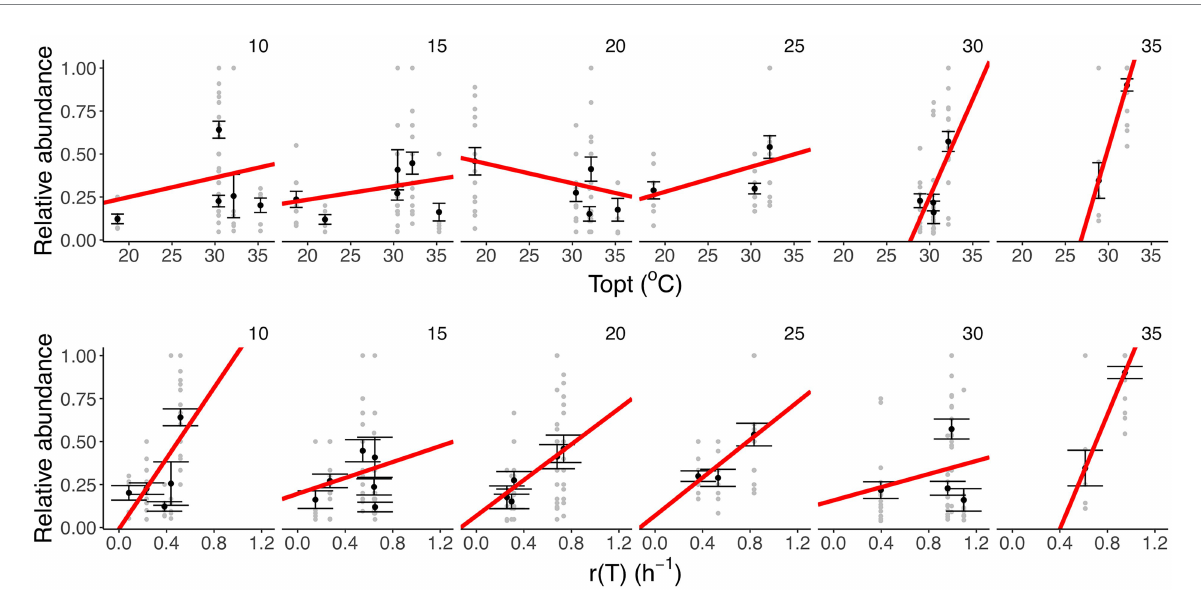
FIGURE 5 Linking taxon-specific thermal traits with relative abundance. Upper row: thermal optima ( T opt, ° C). Lower row: growth rate at the assay temperature [ r (T), h − 1 ]. Each panel represents a temperature treatment. Gray dots represent the relative abundance and taxon-specific thermal trait in each replicate community. The black dots and the error bars represent the averaged relative abundance per taxon and the SEM. The red lines represent the fit of a linear model (see details of model selection in Supplementary Table S4). We found a marked increase in the strength of the correlation between T opt and relative abundance in the high-temperature treatments (30 and 35 ° C), while for r (T) we observe a positive relationship in the slope at all temperature treatments (35 °